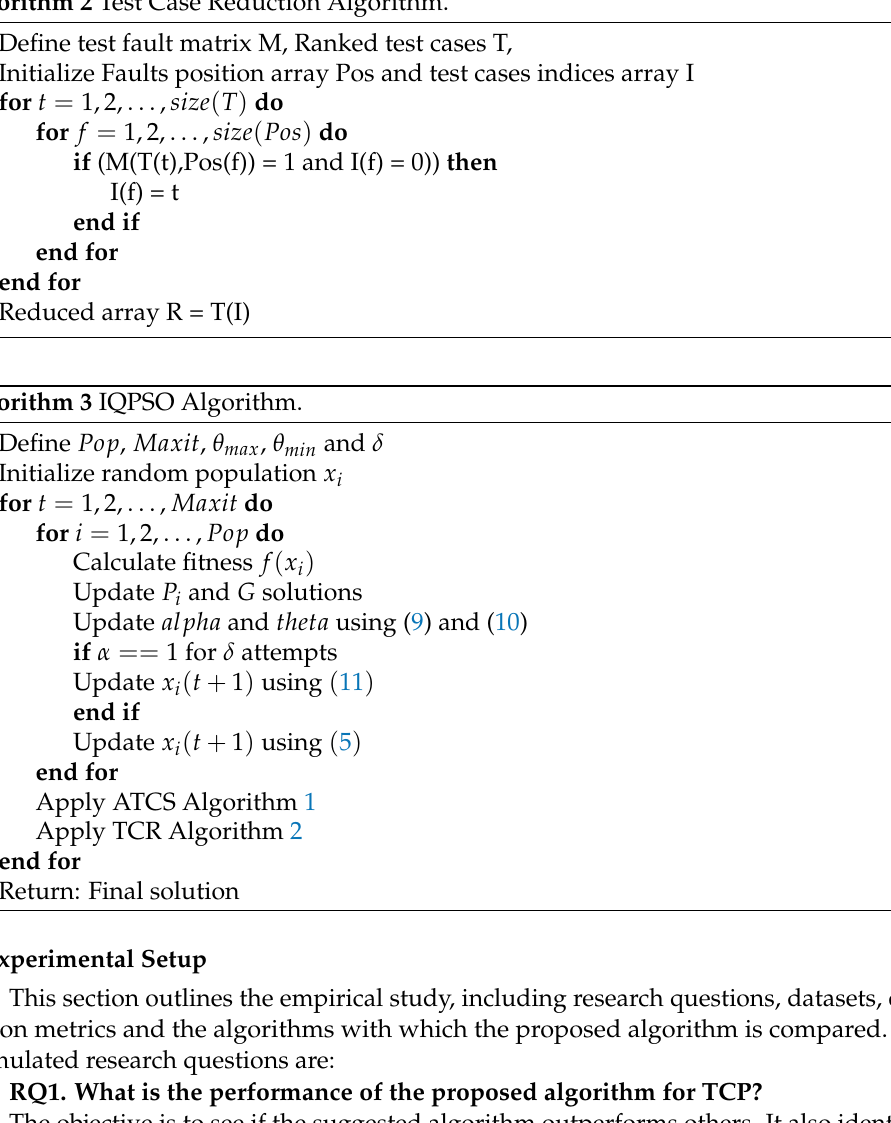
Algorithm 2 Test Case Reduction Algorithm.